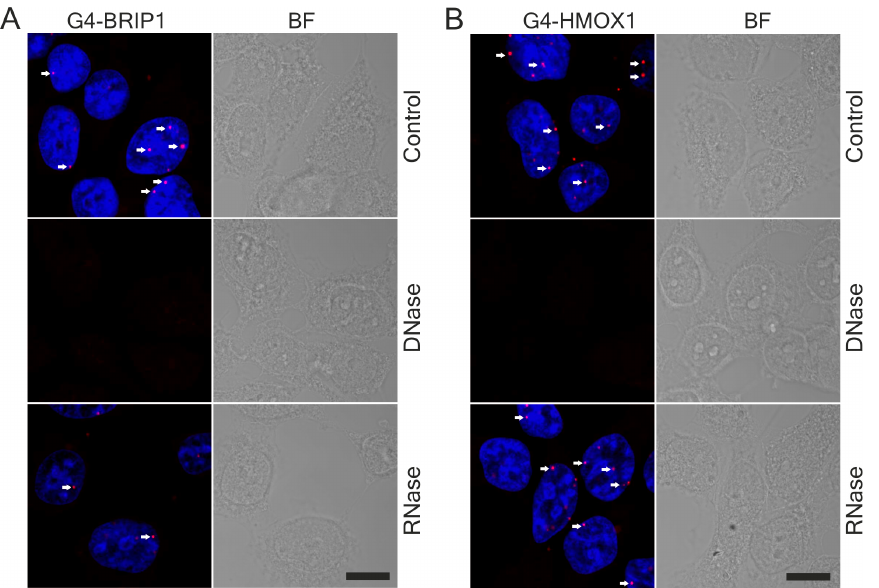
Figure 5. In situ proximity ligation assay (PLA) in HEK293T cells. ( A ) G4-BRIP1 and ( B ) G4-HMOX1 interactions (red dots) were visualized in the control group and after DNase or RNase digestion. Most of the G4 interactions were localized in the nucleus (arrows), but some were also present in the cytoplasm. Cells that were fixed in methanol and mouse 1H6 antibodies were used. Nuclei were counterstained with DAPI (blue), where the transmission bright-field images (BF) show the cell morphologies. Scale bar: 10 μ m.